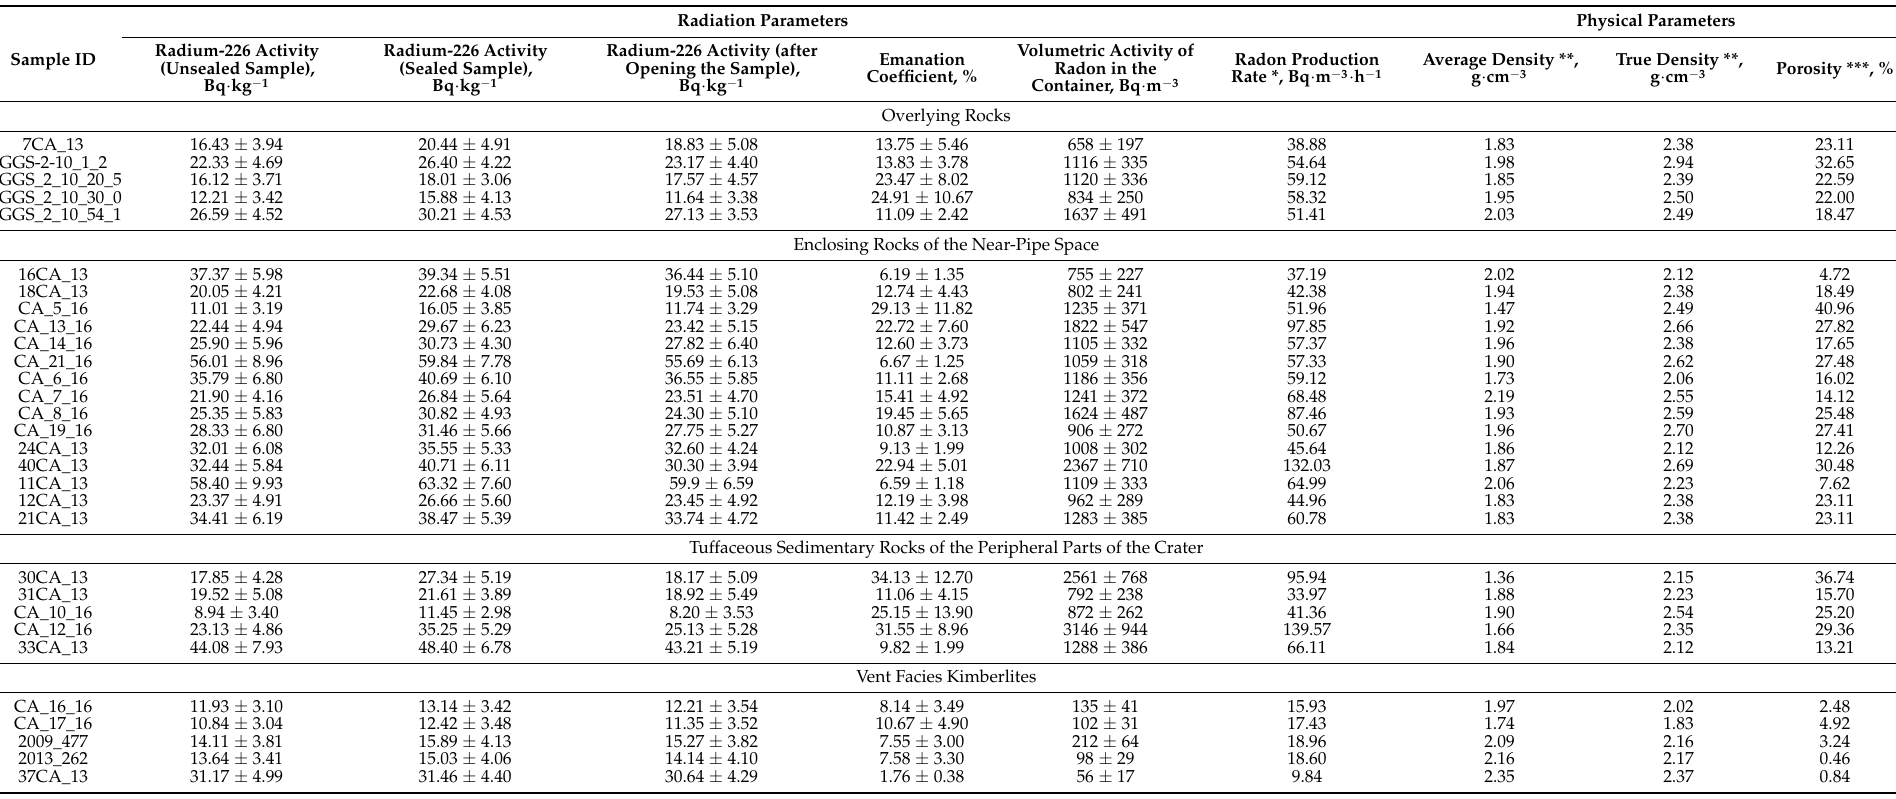
Table A1. Radiation and physical characteristics of studied